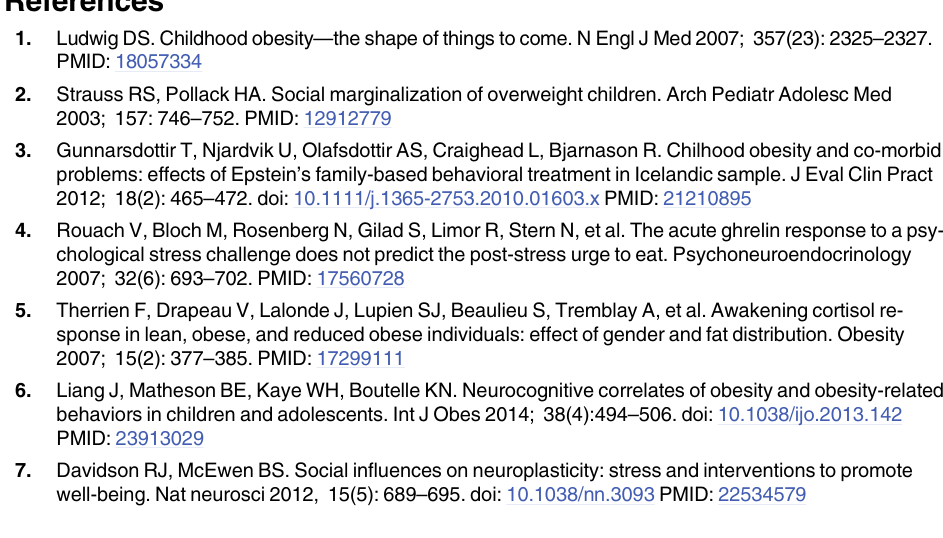
S1 Fig. Power analysis calculations. S2 Fig. Visual Analogue Scales for arousal — left panel- and stress — right panel- in excess and normal weight adolescents before and after the Trier Social Stress Task